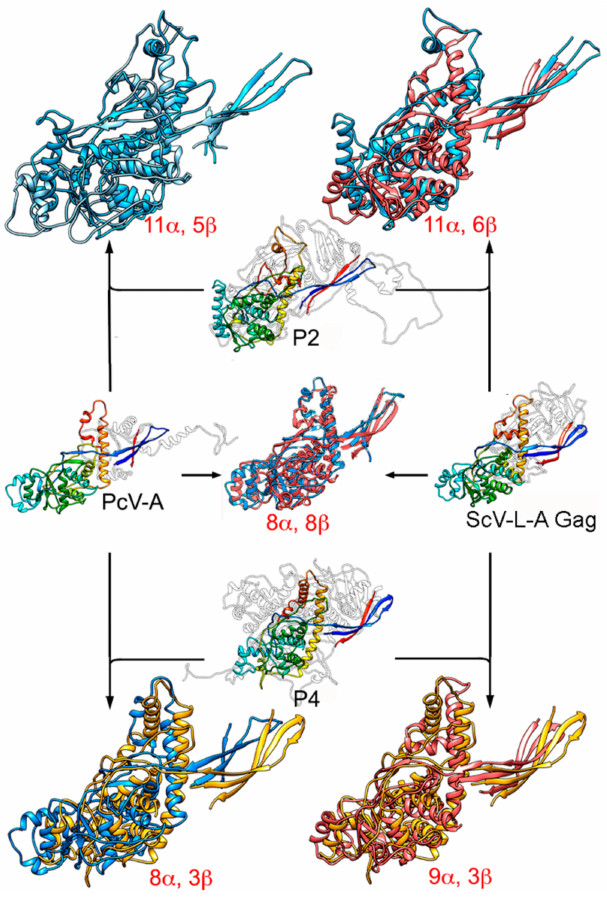
Figure 6. Structural homology of mycovirus T = 1 CP. The PcV CP A domain (PcV-A, left, center) was structurally aligned with ScV-L-A Gag (right, center), and P2 (top, center) and P4 (bottom, center) with PcV-A and ScV-L-A Gag. Center rainbow-colored structures indicate conserved secondary structure elements within the dsRNA viruses. PcV-A is aligned with ScV-L-A Gag (blue and pink, center). P2 is aligned with PcV-A (blue and light blue, top left) and with ScV-L-A Gag (blue and pink, top right). P4 is aligned with PcV-A (yellow and blue, bottom left) and P4 with ScV-L-AL-A Gag (yellow and pink). Total numbers of secondary structural elements with close relative spatial locations are